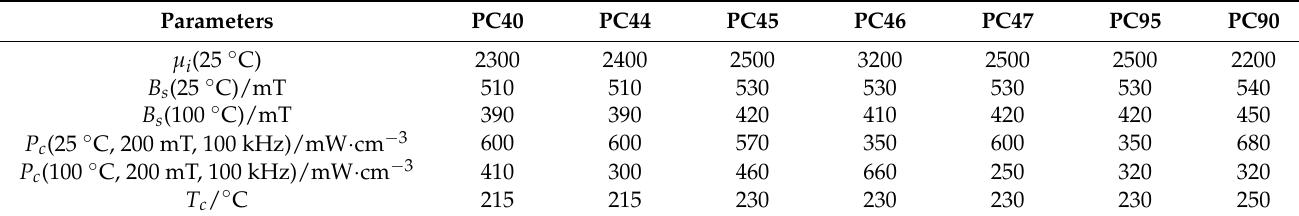
Table 5. TDK’s PC series Mn-Zn ferrites product parameters.